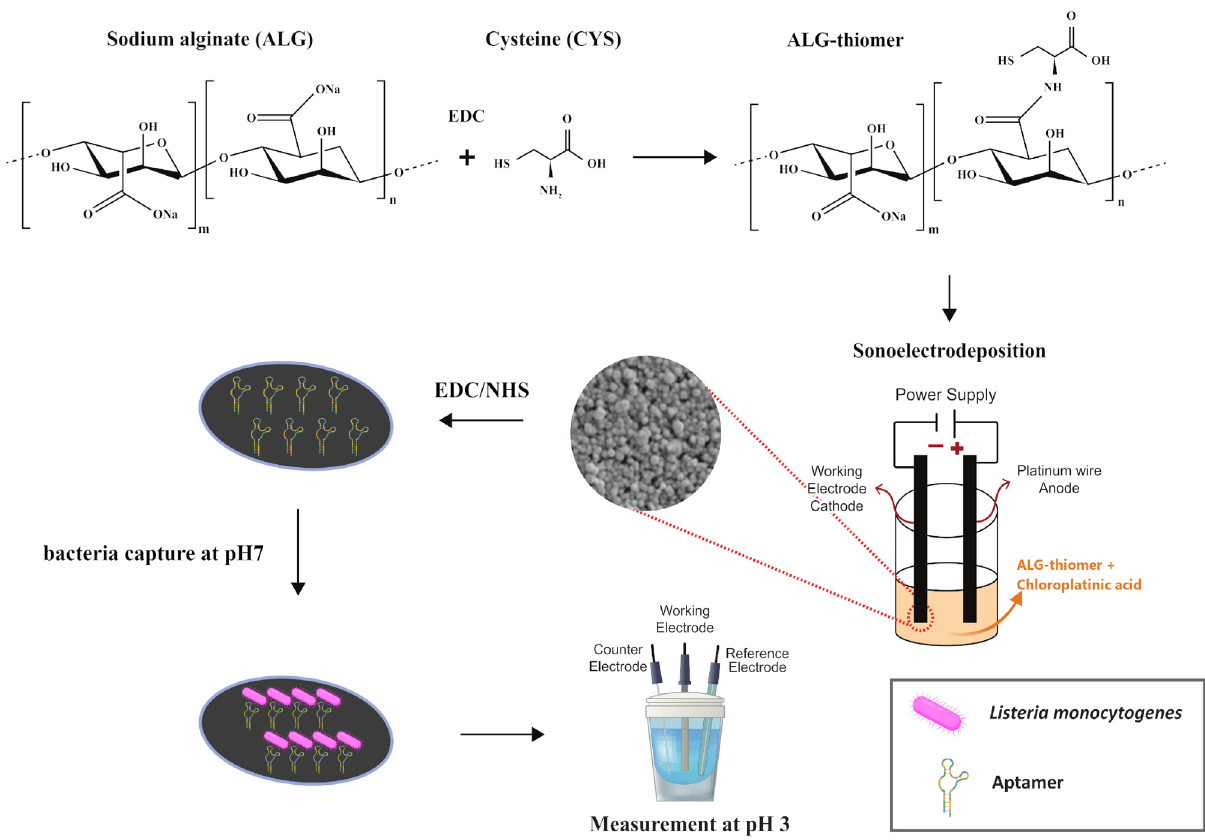
Figure 1. Schematic of the steps for fabrication, biofunctionalization, and sensing of the ALG-thiomer/Pt brushes functionalized with aptamer selective to L. monocytogenes . First, ALG-thiomers are formed based on the reaction of sodium alginate with cysteine using N-(3-dimethylaminopropyl)-N ′ -ethylcarbodiimide (EDC) chemistry. Then, ALG-thiomer and platinum are sonoelectrodeposited simultaneously onto the working electrode, resulting in ALG-thiomer/Pt brushes that are shown via SEM imaging. Next, the